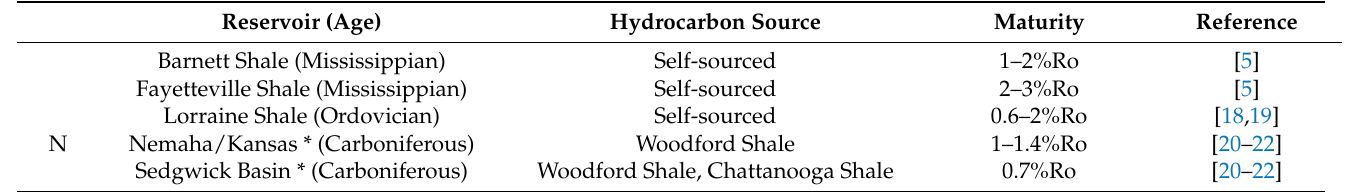
Table 1. Low-permeability reservoirs and conventional (*) reservoirs from which molecular and carbon isotope data of gas samples was included in this